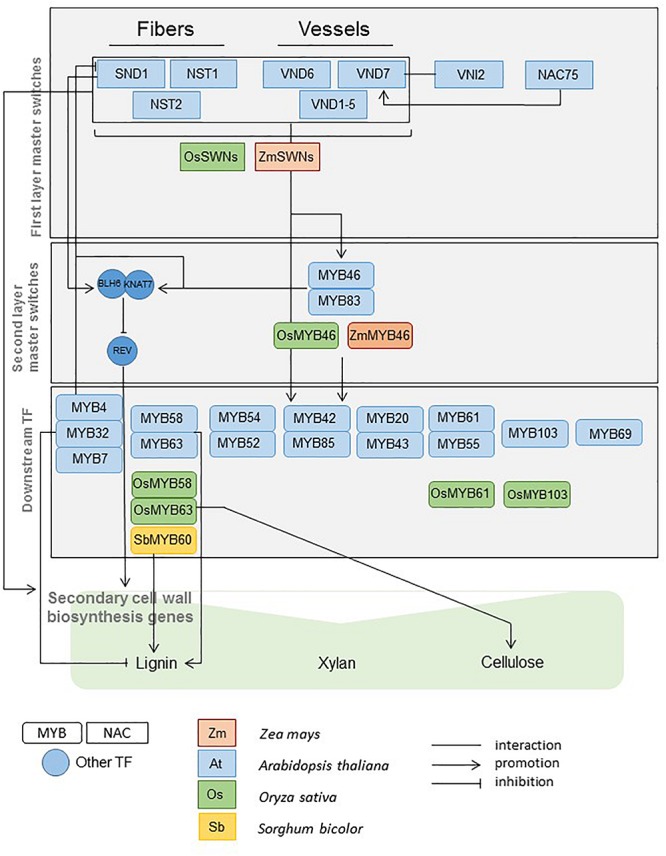
MYB, NAC, and other regulators of SCW biosynthesis functionally validated in Arabidopsis, maize, rice, and sorghum (Adapted from Wang and Dixon, 2012; Liu et al., 2014; Rao and Dixon, 2018).